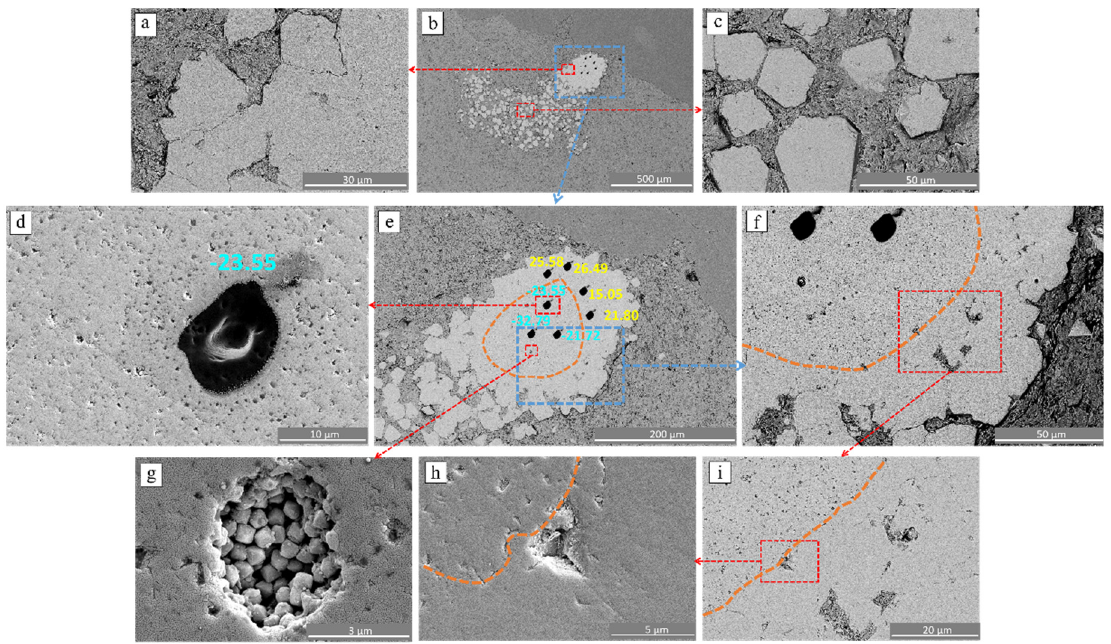
Figure 4. SEM images of an aggregate of large euhedral crystals: ( a ) Large euhedral crystals in the rim of the aggregate; ( b ) General view of the aggregate; ( c ) Separated large euhedral crystals; ( d ) Porous structure in the inner part of the aggregate; and ( e ) δ 34 S values obtained using SIMS. The dashed orange line shows the boundary between inner and outer parts of the aggregate; ( f,h,i ) Red box is section near boundary between inner and outer parts of the large aggregate (inner negative, outer positive); ( g ) Nanocrystals in the inner part; and ( h,i ) Boundary between inner (negative values of δ 34 S) and outer (positive values of δ 34 S) of the aggregate.